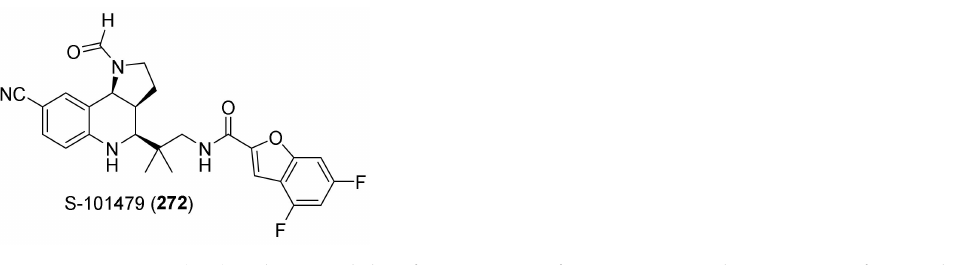
Figure 4. S-101479 ( 272 ), a drug candidate for treatment of postmenopausal osteoporosis from Kaken Pharmaceuticals.